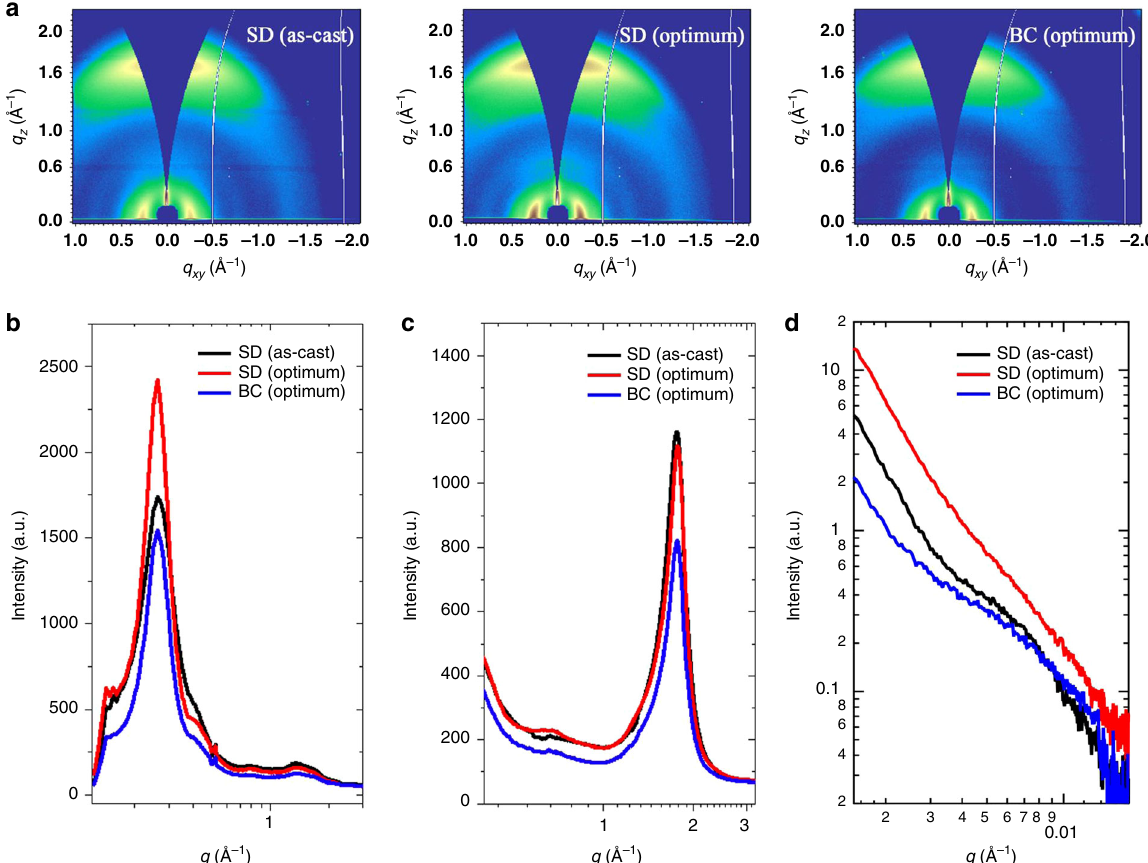
Fig. 4 Morphology characterizations of SD and BC blend fi lms. a 2D GIWAXS diffraction patterns of SD and BC blend fi lms. b In-plane (black lines) and c out-of-plane (red lines) line-cut pro fi les of GIWAXS diffraction patterns. d RSoXS scattering pro fi les of the SD and BC blend fi lms using a photon energy of 284.2